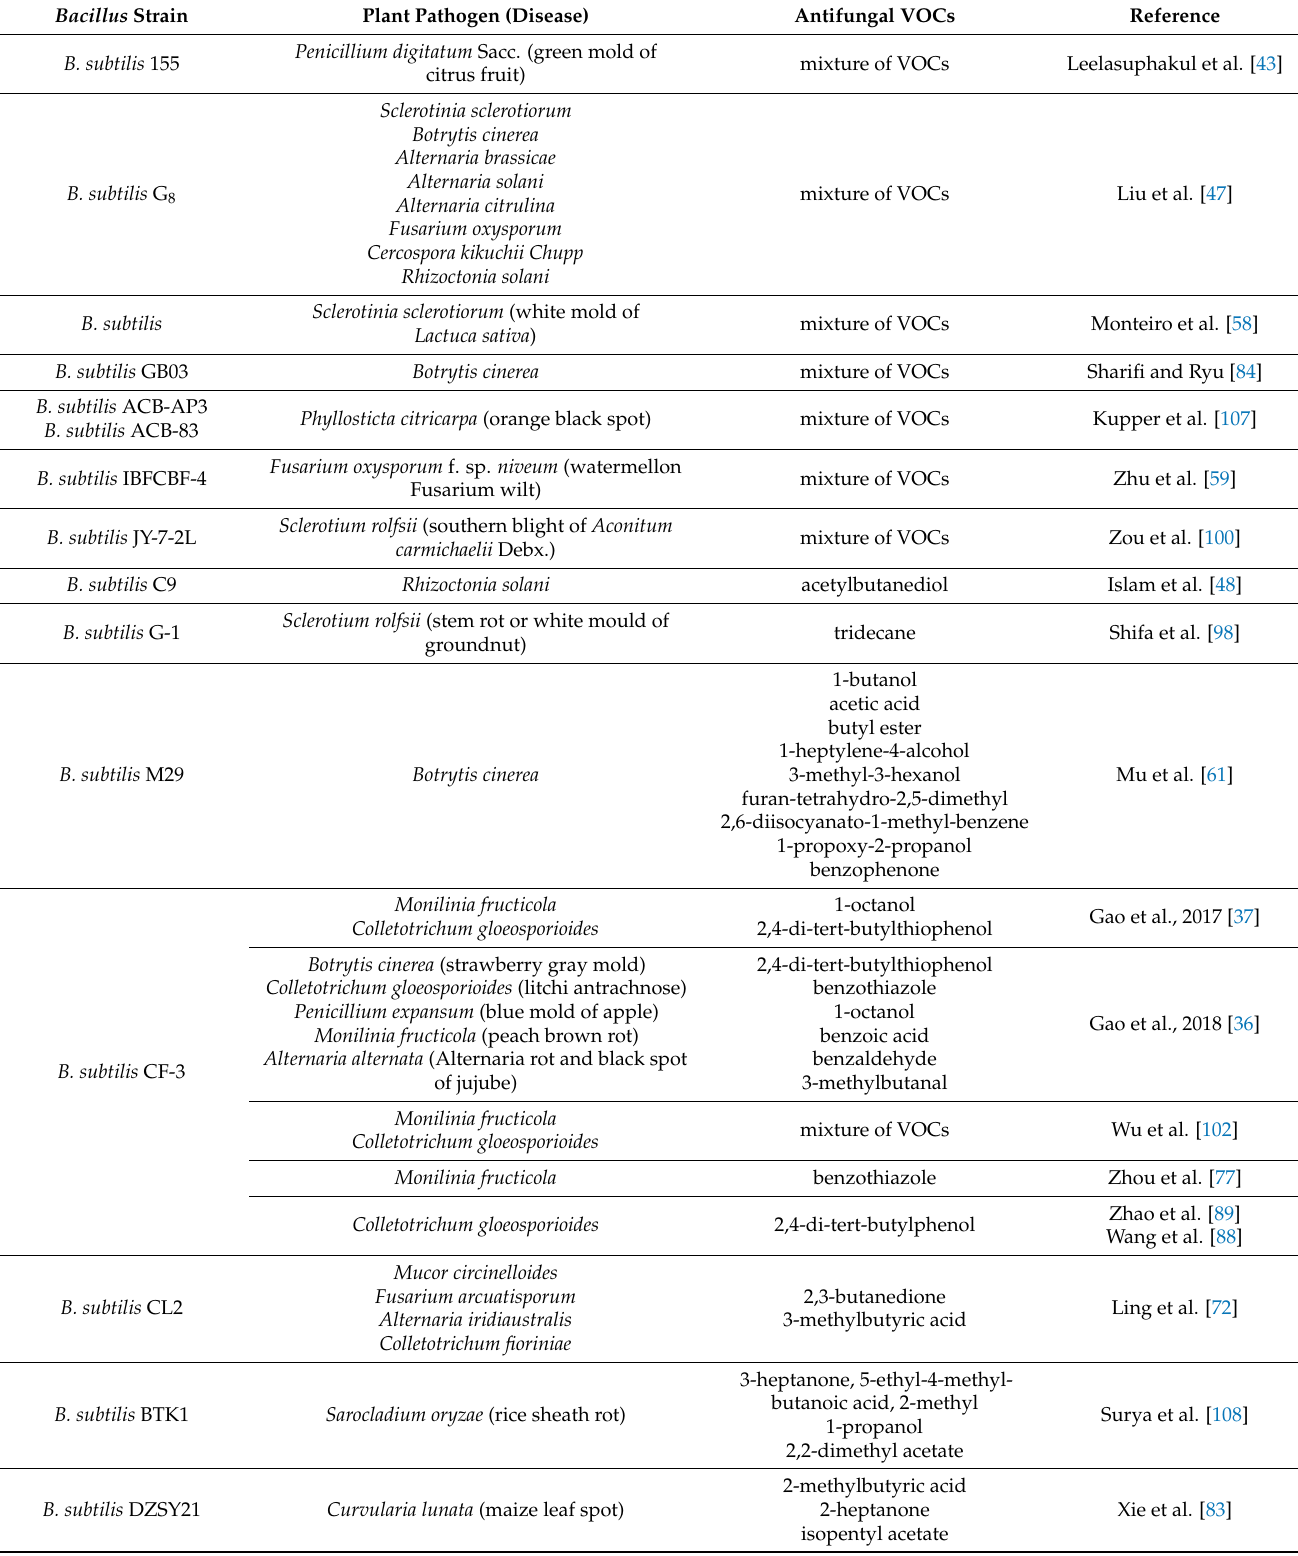
Table 2. Literature overview concerning antifungal VOCs produced by Bacillus